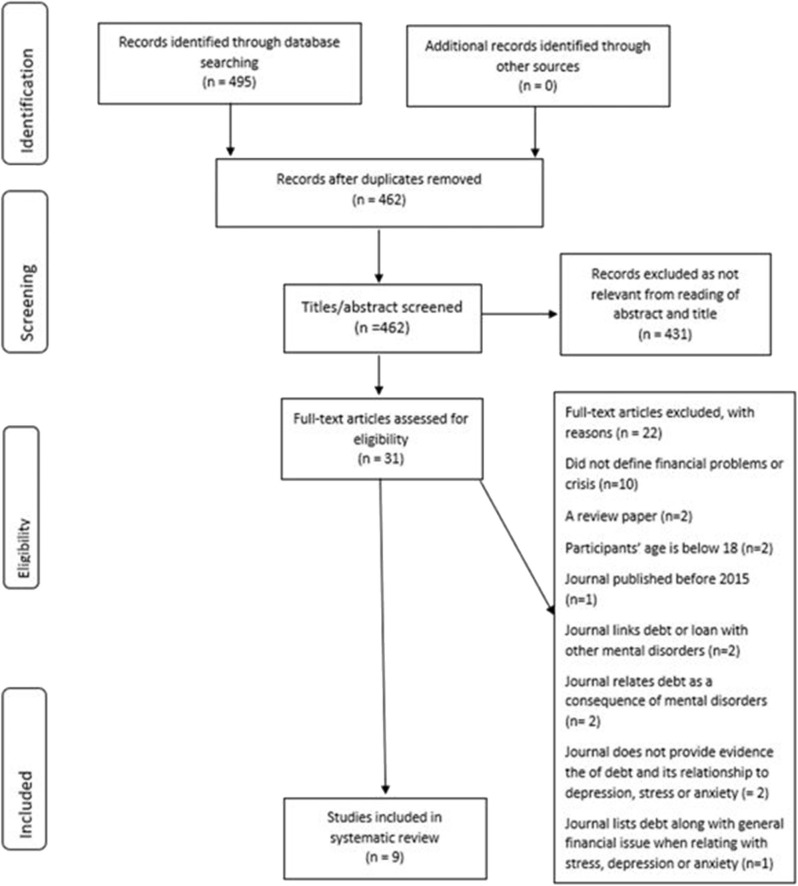
PRISMA flow chart.